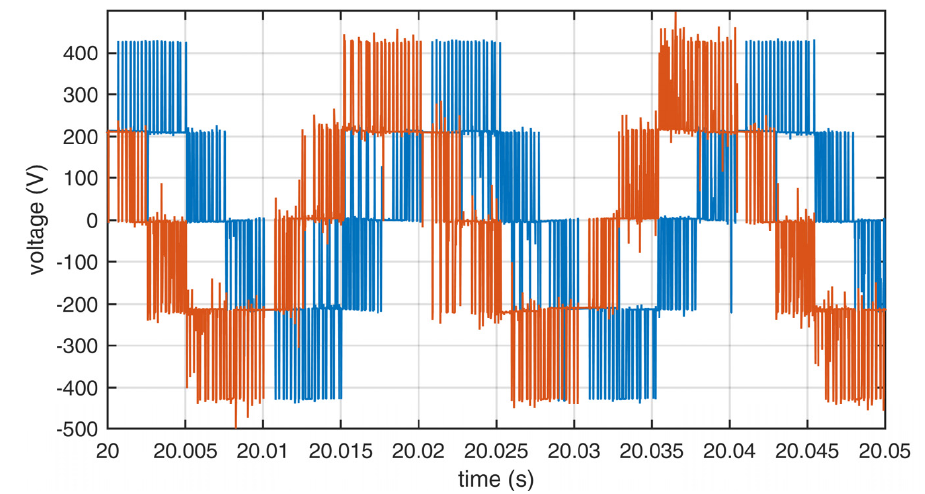
Figure 9. Output line voltages of the inverter using set B. Blue—L1, red—L2.